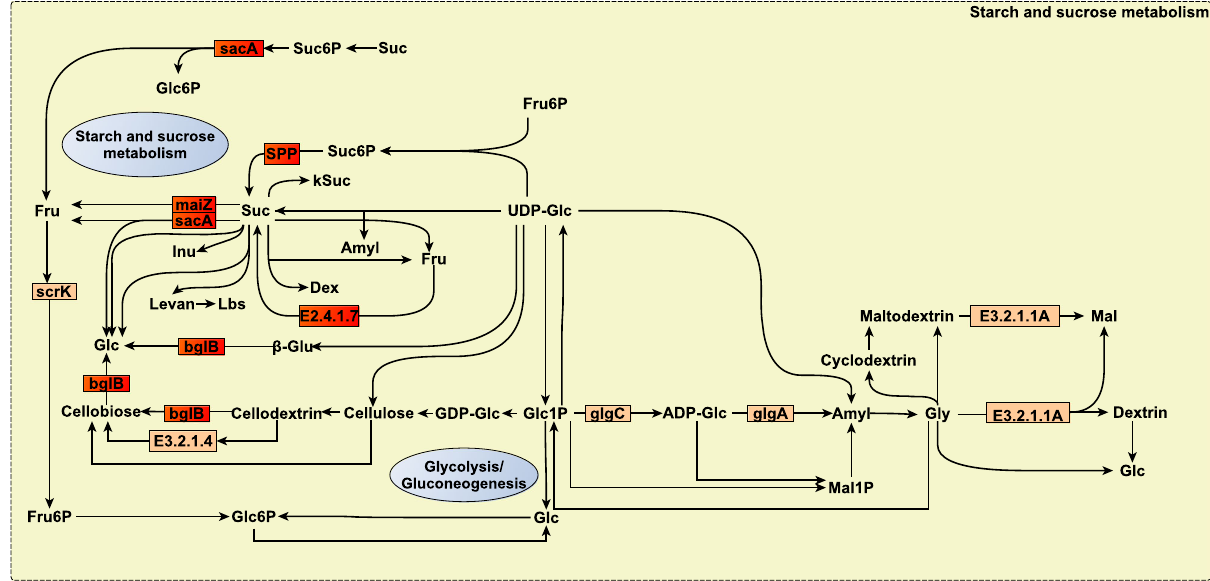
Fig. 5 Reaction scheme of starch and sucrose metabolism in which additive log-ratio transformed microbial gene abundances strongly host genomically correlated with methane emissions ( r gCH4 ) are involved. Small rectangles symbolize proteins encoded by the microbial genes. Microbial genes are highlighted in red when their r gCH4 estimates range between − 0.74 and − 0.93 and show a probability of being different from 0 ( P 0 ) ≥ 0.95, and in orange when they range between |0.55| and |0.77| and P 0 ≥ 0.85. Source data is in Supplementary Data 9. Compounds are denoted by their short names. Full names of compounds and microbial genes are given in Supplementary Data